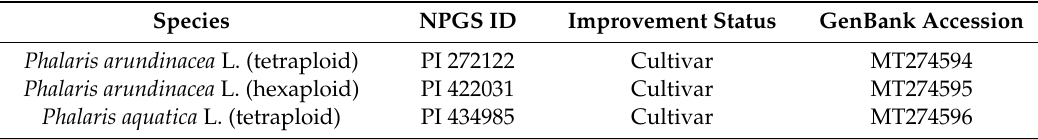
Table 4. Accession information for three Phalaris